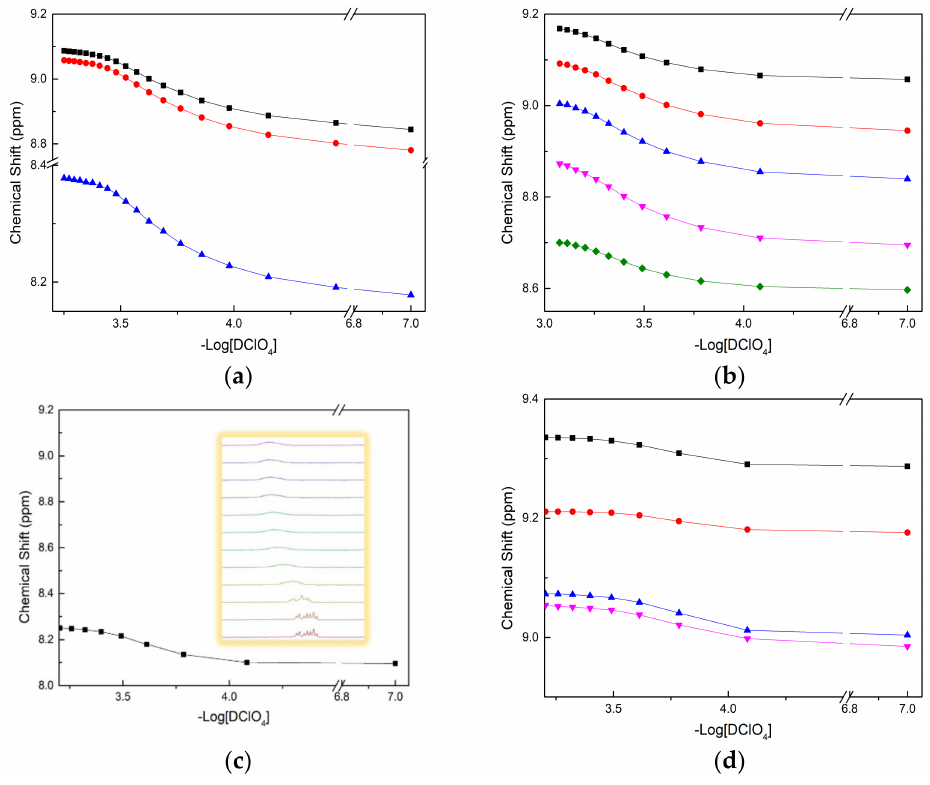
Figure 4. Plot of chemical shift ( δ , ppm) as a function of pD for the H 1 signals with addition of DClO 4 in CD 3 OD: ( a ) Description of chemical shift in L 1 ( (cid:4) —H at C3(or 8), • —H at C4(or 7), (cid:78) —H at C5 (or 6)); ( b ) Description of chemical shift in L 2 ( (cid:4) —H at C8, • —H at C3, (cid:78) —H at C7, (cid:72) —H at C4, (cid:4) —H at C6); ( c ) Description of chemical shift in L 3 ( (cid:4) —H at C6); ( d ) Description of chemical shift in L 4 ( (cid:4) —H at C8, • —H at C3, (cid:78) —H at C7, (cid:72) —H at